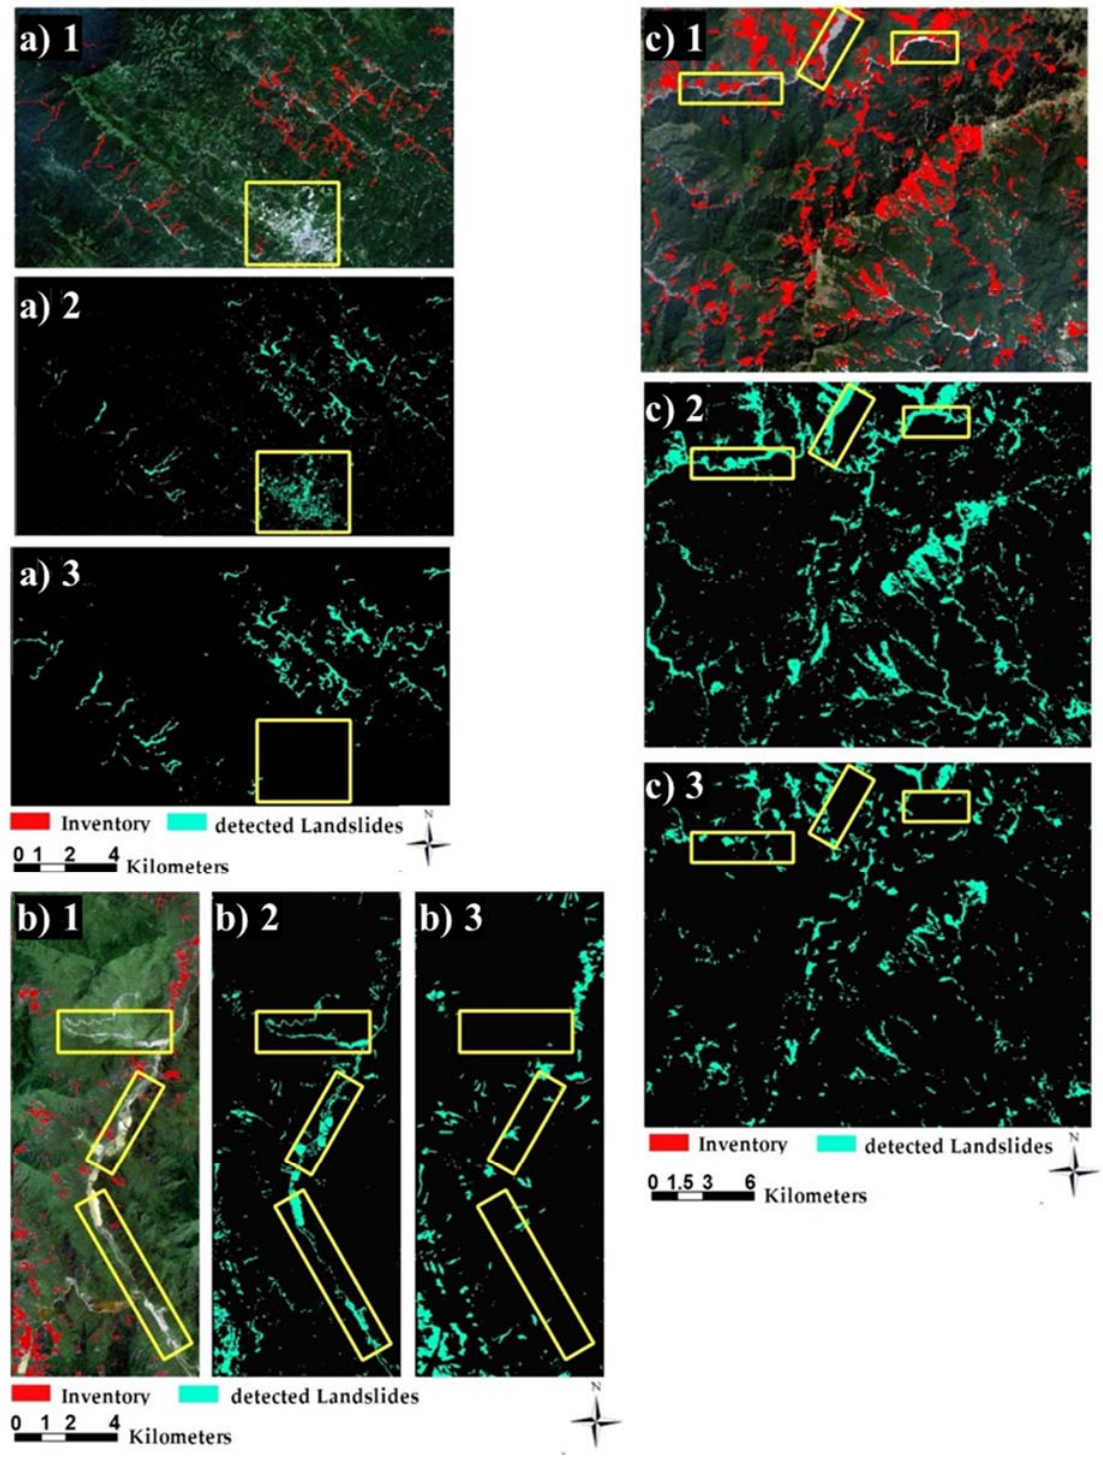
Figure 16. Illustration the landslide detection results for ( a ) India, ( b ) China, and ( c ) Taiwan. The numbers of 1, 2, and 3 are represent the Sentinel-2 image, detected landslides based on clustering of MNF features, slope, and NDVI, and detected landslides based on clustering of deep features, respectively. Yellow box in ( a ) indicates a residential area, while ( b , c ) show the riverbeds.